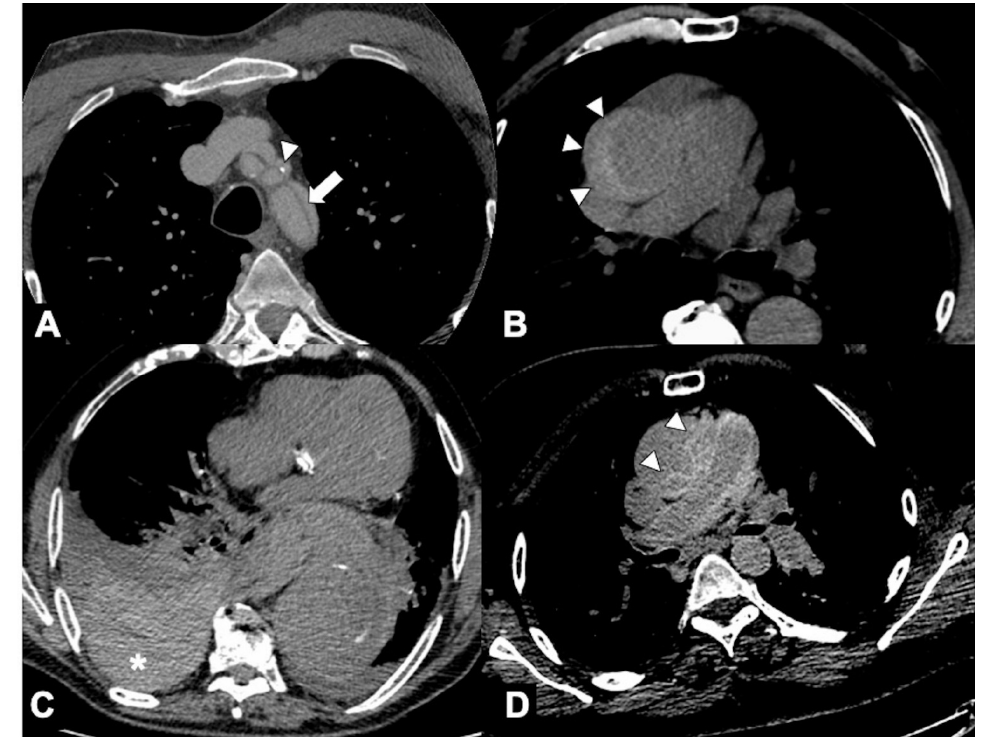
Figure 2. Usefulness of CTA low-dose unenhanced phase in acute aortic syndrome. ( A ) Noncontrast CT axial scan shows dissection flap (arrow) and displaced intimal calcifications (arrowhead) in supra-aortic vessels extension of type A aortic dissection in a 79-year-old-man with acute neck and back pain. ( B ) Axial image from noncontrast CT shows a crescent-shaped high-density rind in the ascending aorta, a typical appearance of type A acute intramural hematoma (arrowheads). ( C ) Noncontrast CT axial scan shows a large bilateral pleural effusion with increased density in the dependent aspect of the collection (hematocrit sign), highly suggestive of hemothorax (asterisk) from rupture of the descending thoracic aorta aneurysm. ( D ) Axial image of aorta from noncontrast CT shows hemomediastinum tracking along the main and right pulmonary arteries and hyperattenu- ating dissection flap (arrowheads) in ascending aorta in a 68-year-old woman with ruptured type A